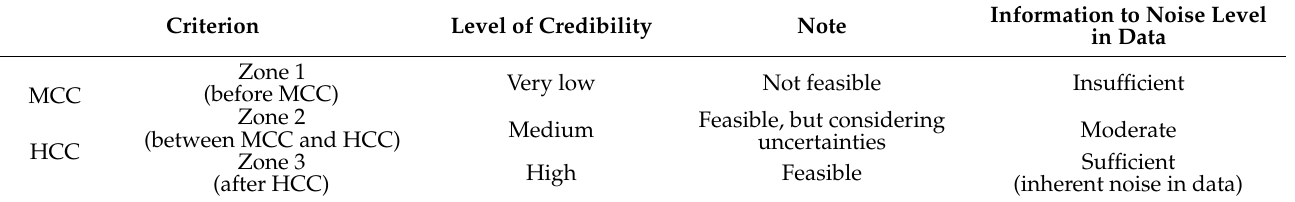
Table 1. Characteristic of the credibility zones.